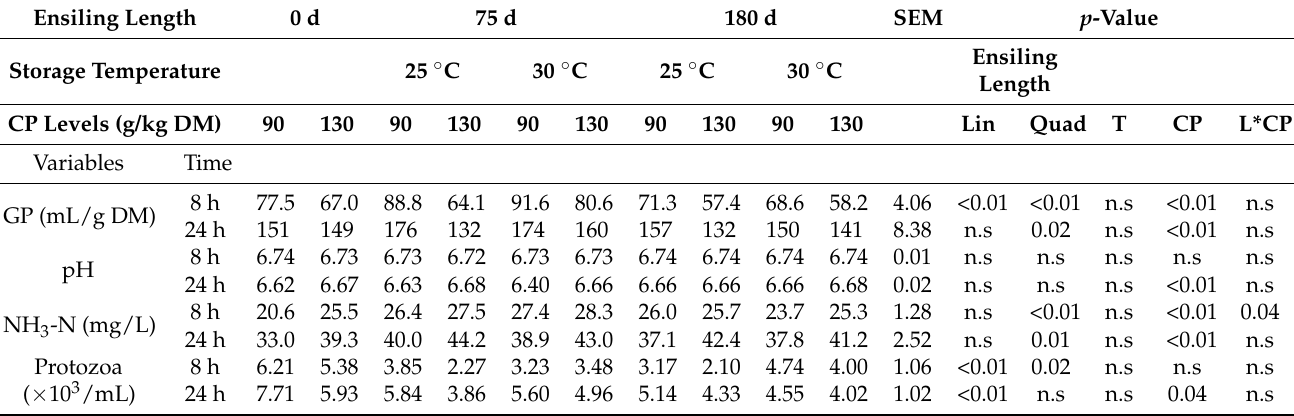
Table 3. Effect of ensiling length (L), storage temperature (T), and crude protein (CP) level on gas different incubation periods (least squares means; n =